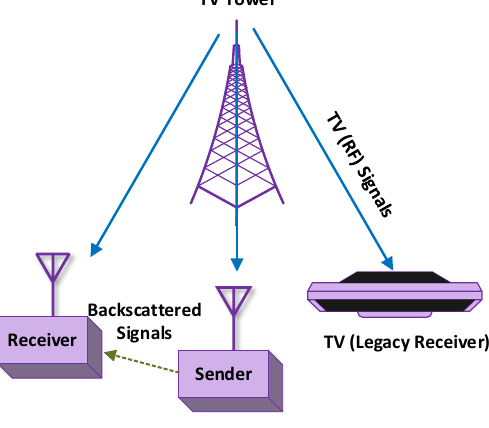
Figure 3. Passive tags communicating using backscatter communication